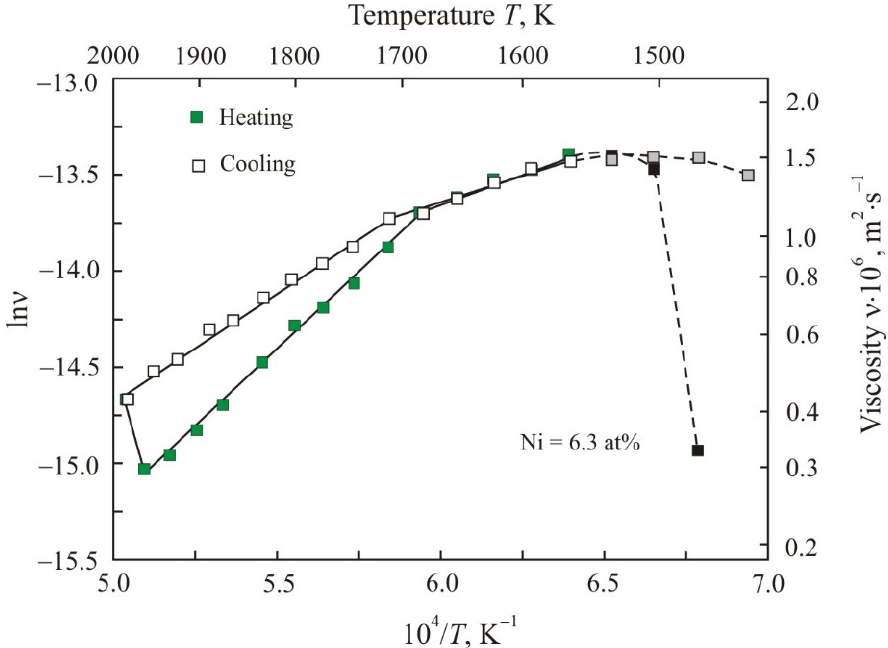
Figure 2. Kinematic viscosity on a natural logarithmic scale ln ν as a function of the inverse absolute temperature T − 1 upon heating to maximum temperature T max = 1985 K and cooling the Fe 72.5 − x Ni x Cu 1 Nb 2 Mo 1.5 Si 14 B 9 alloys with Ni content 6.3 at. %.